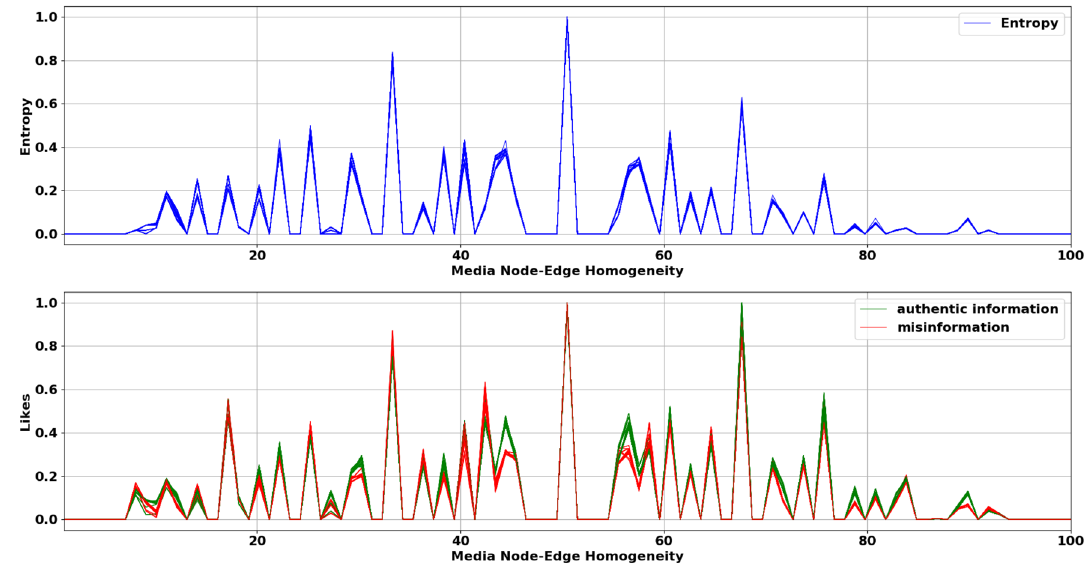
Figure 5. Normalized entropy response and normalized likes distribution against media node-edge homogeneity in the in-degree